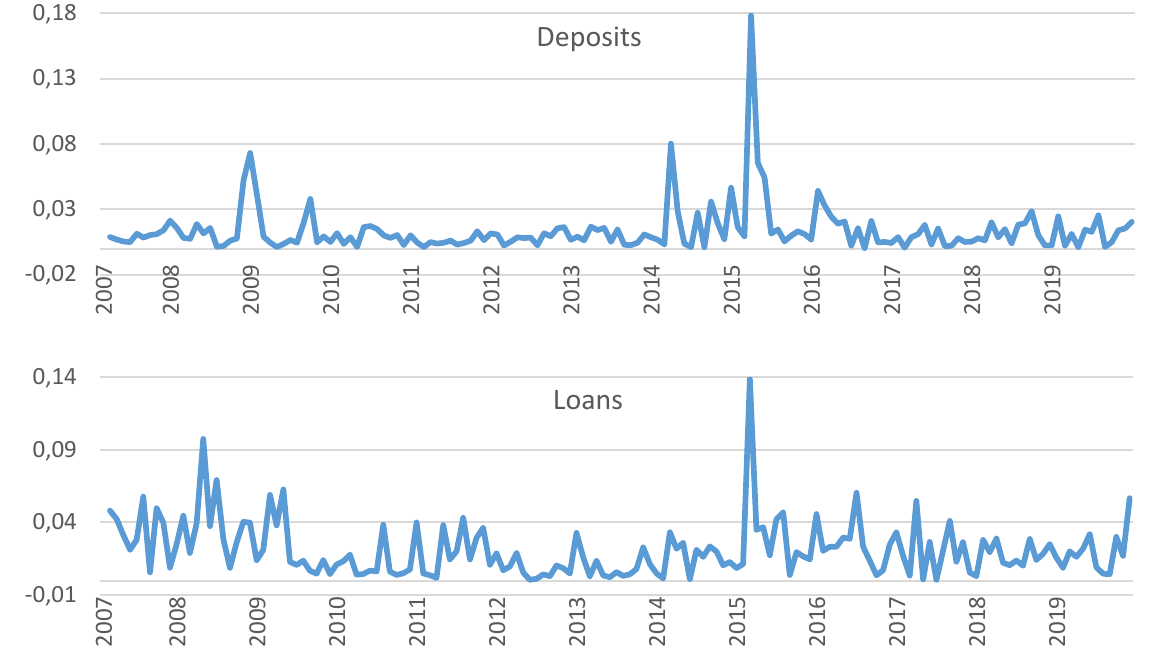
Figure 8. Dynamics of integrated indices of structural changes (Gatev coefficient) in terms of